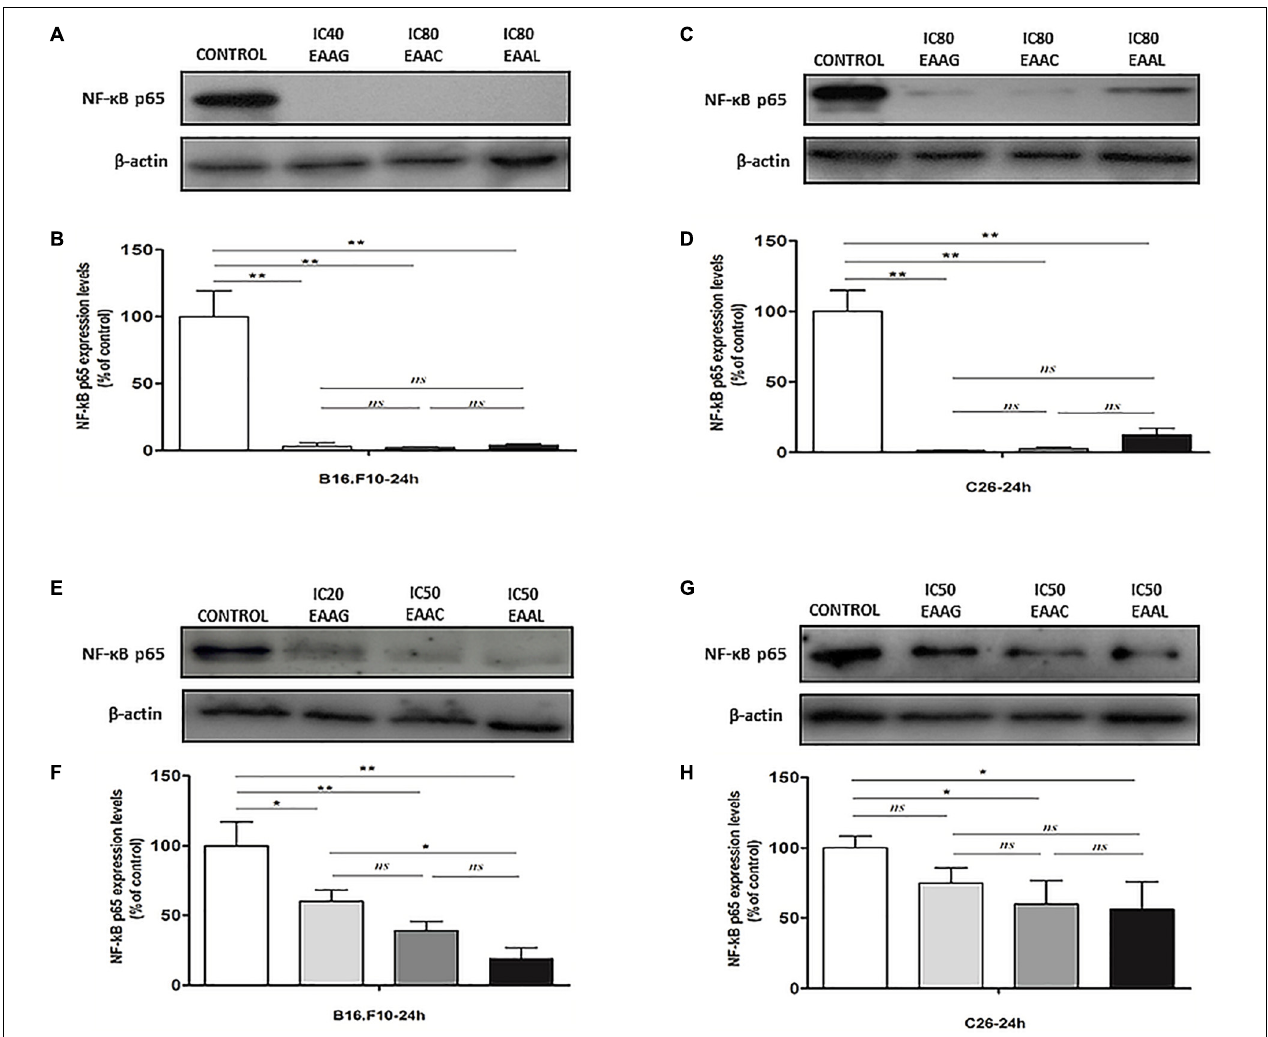
FIGURE 6 | The expression of NF- κ B-p65 in cell lysates after different treatments. Western blot analysis of total NF- κ B-p65 expression in cell lysates from (A,E) B16.F10 cells and (C,G) C26 cells after different treatments; β -actin was used as loading control. (B) % of NF- κ B-p65 expression relative to control in B16.F10 melanoma cells after IC 40 EEAG, IC 80 EEAC, and IC 80 EEAL treatments. (F) % of NF- κ B-p65 expression relative to control in B16.F10 melanoma cells after IC 20 EEAG, IC 50 EEAC, and IC 50 EEAL treatments. (D) % of NF- κ B expression relative to control in C26 colon carcinoma cells after IC 80 EEAG, IC 80 EEAC, and IC 80 EEAL treatments. (H) % of NF- κ B expression relative to control in C26 colon carcinoma cells after IC 50 EEAG, IC 50 EEAC, and IC 50 EEAL treatments. On B16.F10 cells: Control, untreated cells; IC 40 or IC 20 EEAG, cells incubated with 650 µ g/mL or 260 µ g/mL A. genevensis ethanolic extract; IC 80 or IC 50 EEAC, cells incubated with 650 µ g/mL or 406.7 µ g/mL A. chamaepitys ethanolic extract; IC 80 or IC 50 EEAL, cells incubated with 325 µ g/mL or 236.8 µ g/mL A. laxmannii ethanolic extract. On C26 cells: Control, untreated cells; IC 80 or IC 50 EEAG, cells incubated with 650 µ g/mL or 457.5 µ g/mL A. genevensis ethanolic extract; IC 80 or IC 50 EEAC, cells incubated with 650 µ g/mL or 303 µ g/mL A. chamaepitys ethanolic extract; IC 80 or IC 50 EEAL, cells incubated with 325 µ g/mL or 176.3 µ g/mL A. laxmannii ethanolic extract. Results represent the mean ± SD of two independent measurements. One way ANOVA test with Bonferroni correction for multiple comparisons was used to analyze the effects of different treatments on the levels of NF- κ B-p65 in comparison with the pro-inflammatory transcription factor production in control (ns, P > 0.05; ∗ P < 0.05; ∗∗ P < 0.01).